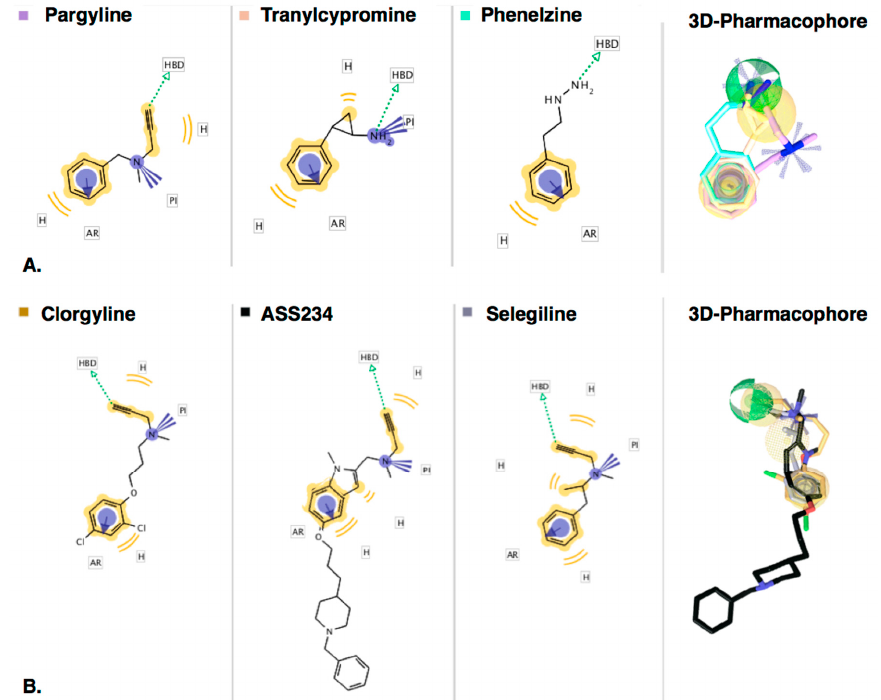
Figure 3. Comparison of chemical features of MAO inactivators derived using ligand-based modeling. 2D-depictions of ( A ) phenelzine (pink), tranylcypromine (beige) and pargyline (cyano) and ( B ) clorgyline (gold), ASS234 (black) and selegiline (gray) aligned to the respective resulting 3D-pharmacophore models (3D-alignments of ligands with the models are to the right). Hydrogens are not displayed. Hydrophobic-aromatic and H-bond donor features were shared by all inactivators in the same 3D-positions. Clorgyline, ASS234, selegiline, and pargyline shared a positive ionizable feature in the same 3D-geometries, whereas the positive ionizable feature of tranylcypromine is in a different geometric space. Hydrophobic (H) features (yellow spheres), aromatic (AR) (blue doughnut-3D or blue circle-2D), positive ionizables (PI) (blue stars) and hydrogen-bond donor (HBD) (green sphere). The pharmacophore models and images were generated using LigandScout 4.4 Expert [43].